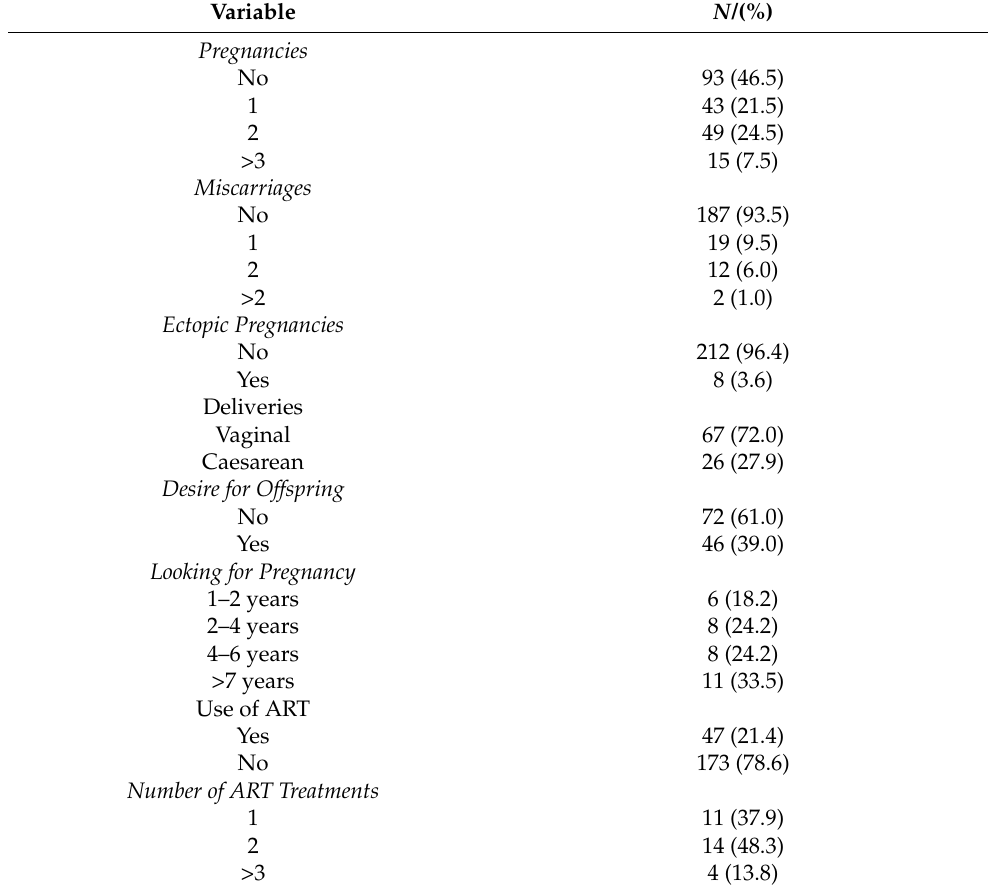
Table 1. Reproductive